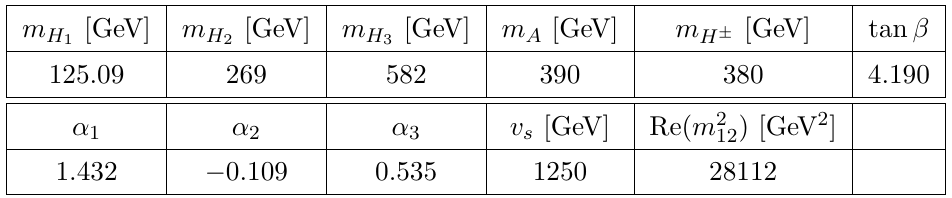
in GeV, c H 2 H 2